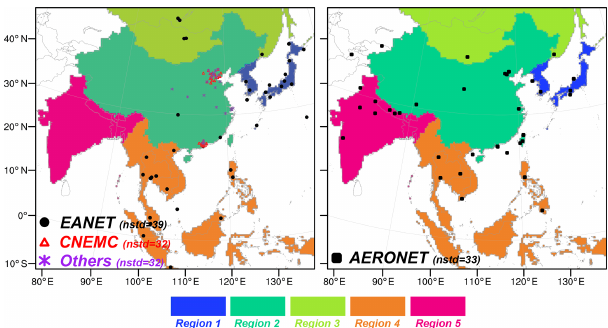
Figure 2. The geographical locations of observation stations: EANET (shown in black circles; the number of stations is 39), CNEMC (shown in red triangles; the number of stations is 32), oth- ers (observations collected from published literature, shown in pur- ple stars; the number of stations is 32), and AERONET (shown in black boxes; the number of stations is 33). Five defined subregions (Region_1 to Region_5) are also